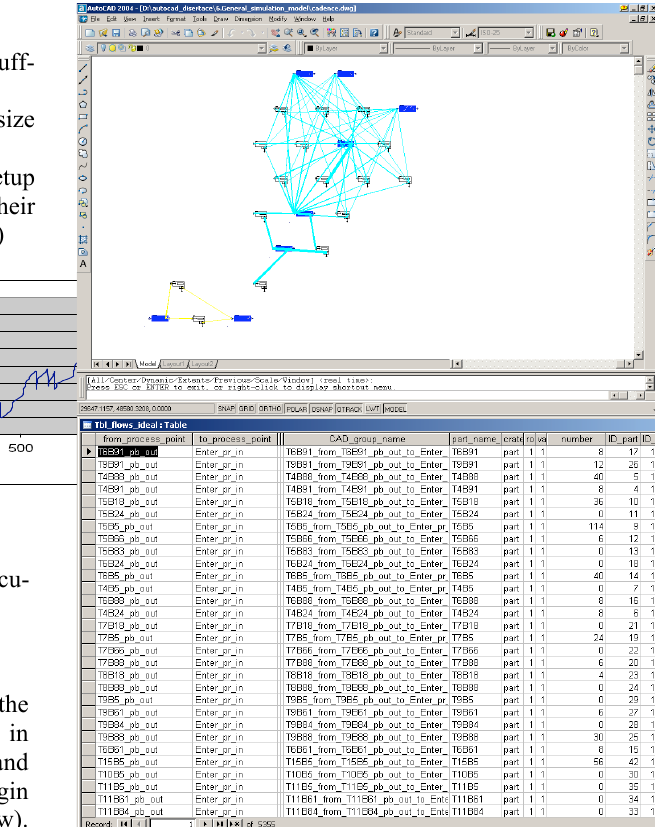
Fig. 11. Displaying of material